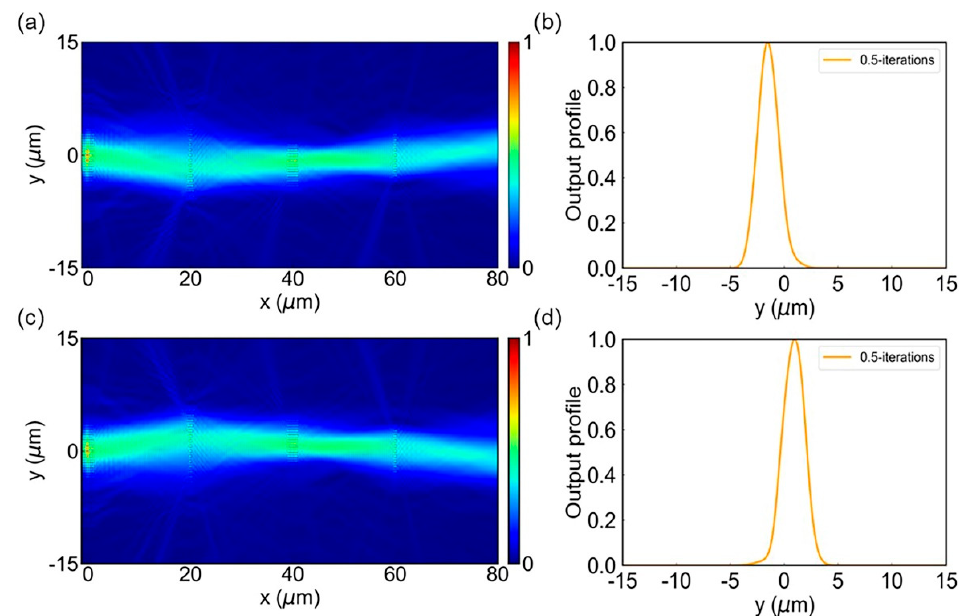
Figure 5. Theoretical simulation of the on-chip quantum search algorithm. ( a , c ) The snapshots for the intensity of the incident microwave throughout the metamaterial functioning as quantum searching simulator with 0.5-iterations: ( a ) y 1 = − 2.75 μ m and y 2 = − 1.25 μ m, ( c ) y 1 = 1.25 μ m and y 2 = 2.75 μ m. ( b , d ) Simulation results for the normalized output intensity of the metamaterial with the incident wave propagating 0.5-roundtrips within the device: ( b ) y 1 = − 2.75 μ m and y 2 = − 1.25 μ m, ( d ) y 1 = 1.25 μ m and y 2 = 2.75 μ m.